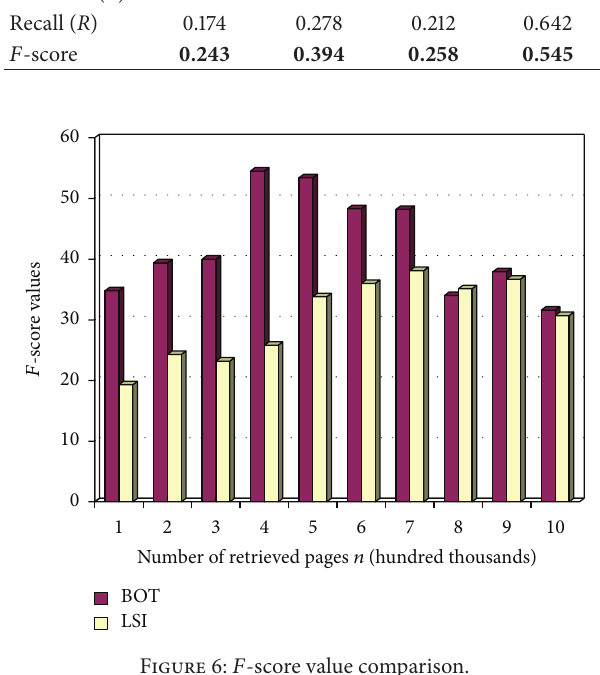
Figure 6: 𝐹 -score value